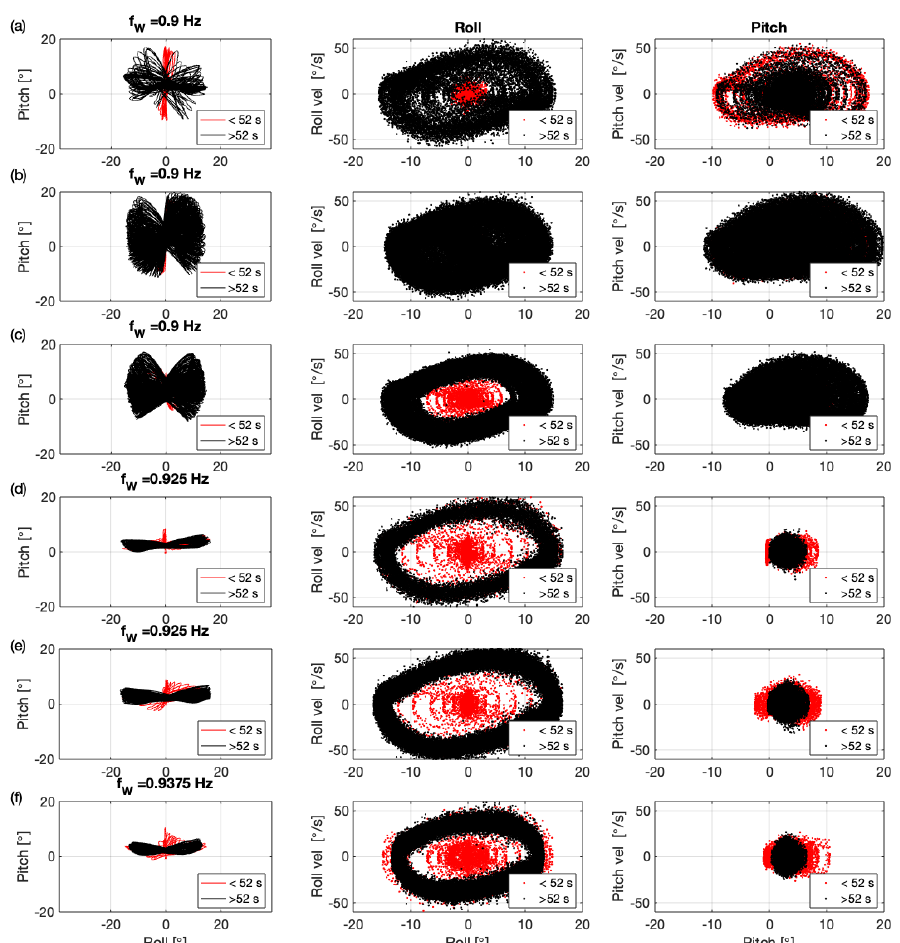
Figure 9. Direct comparison of pitch and roll as well as the comparison of pitch and roll angle with the corresponding velocity for the time series presented in Figure 8—( a ) f W = 0.90 Hz, 180 s, ( b , c ) 0.90 Hz, 512 s, ( d ) 0.925 Hz, 180 s, ( e ) 0.925 Hz, 512 s, ( f ) 0.9375 Hz, 512 s—the first 52 s are presented in